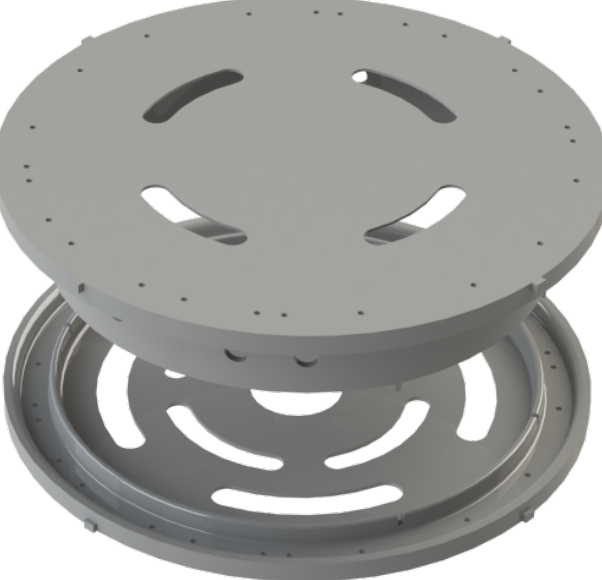
Figure 5. Graphic rendering of the central/main elements of the